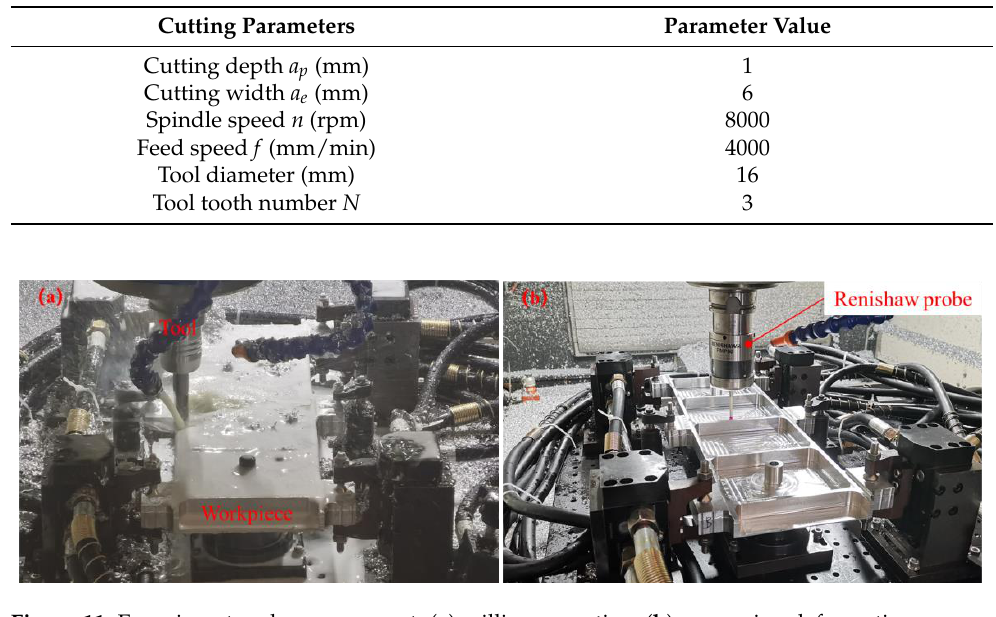
Figure 10. The process route of workpiece machining.